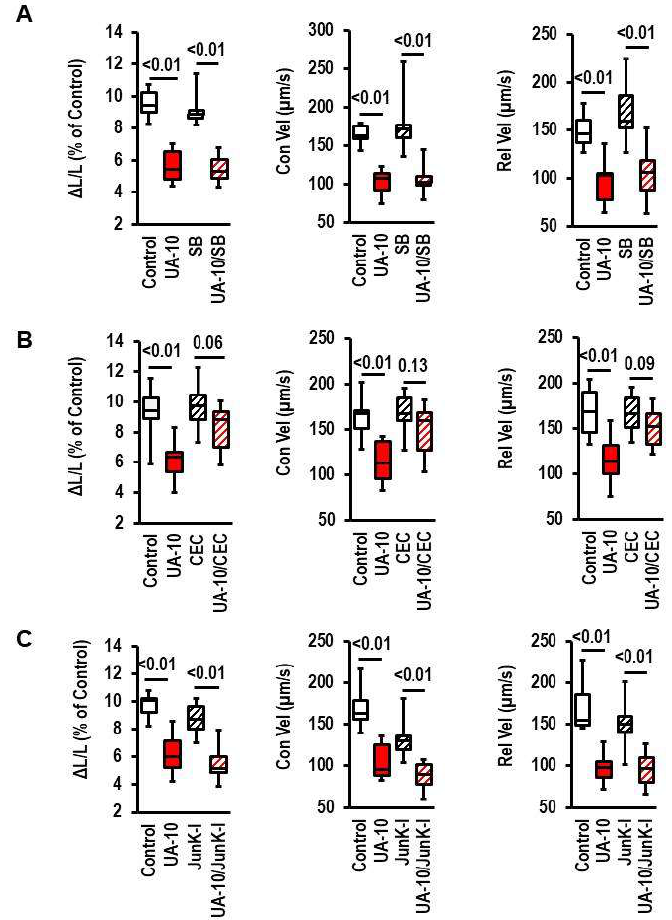
Figure 5. Effect of inhibition of signal transduction pathways on cell shortening and uric-acid (UA)- induced effects. Cells were exposed to SB202190 (SB; 10 µmol/L), chelerythrine chloride (CEC, 10 µmol/L), or SP600125 (SP, 10 µmol/L) and UA-10 (10 mg/dl). Data show the effects on cell shortening (( A ) ; ΔL/L), contraction velocity (( B ); Con Vel), and relaxation velocity (( C ); Rel-Vel). Data are ex- pressed as bars and whiskers with median, 25% quartile, 75% quartile indicated by bars, and com- plete range by whiskers. Statistical analysis is based on Student t -tests and exact p -values are indi- cated. Data are means from n = 10 (each) preparations (rats), with 4 cell culture dish per preparation and 9 cells evaluated per cell culture dish. Statistical analysis is based on preparations.